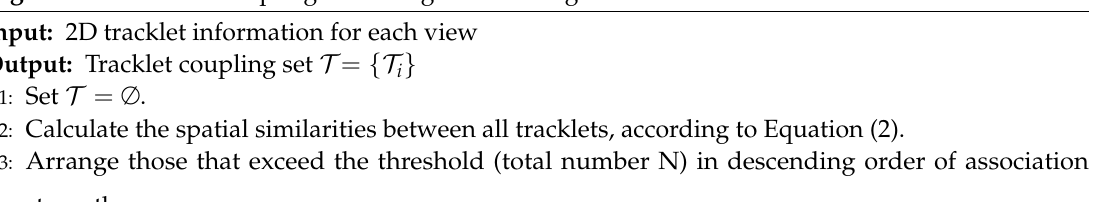
Algorithm 1 Tracklet coupling iterative generation